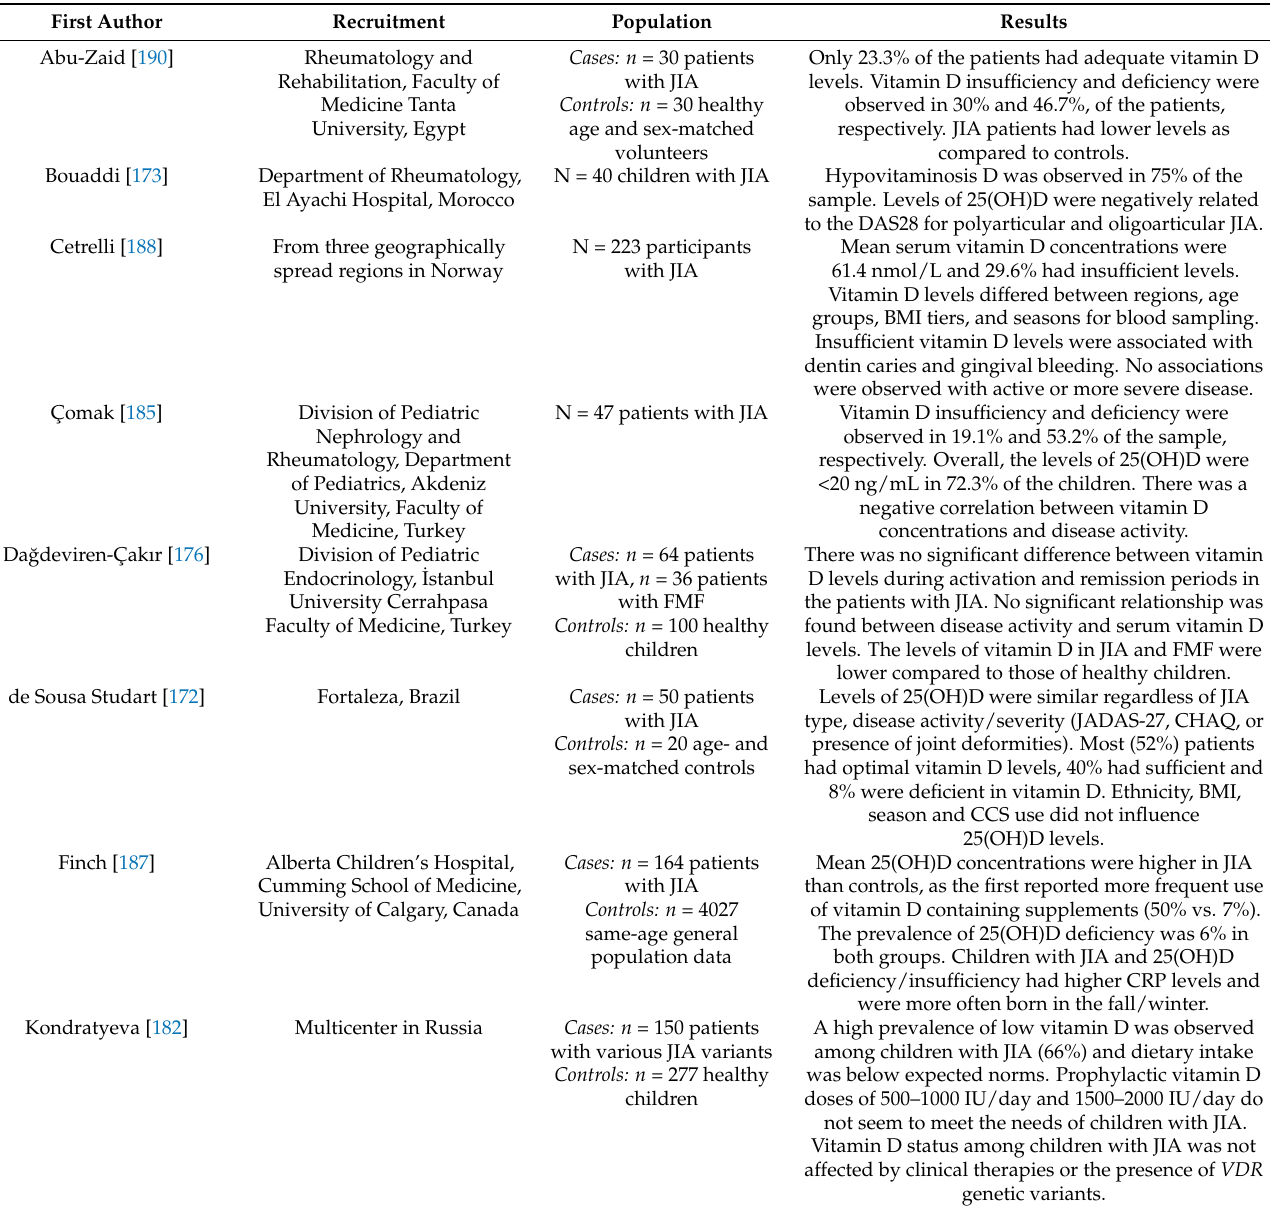
Table 5. Primary research on vitamin D status in children with